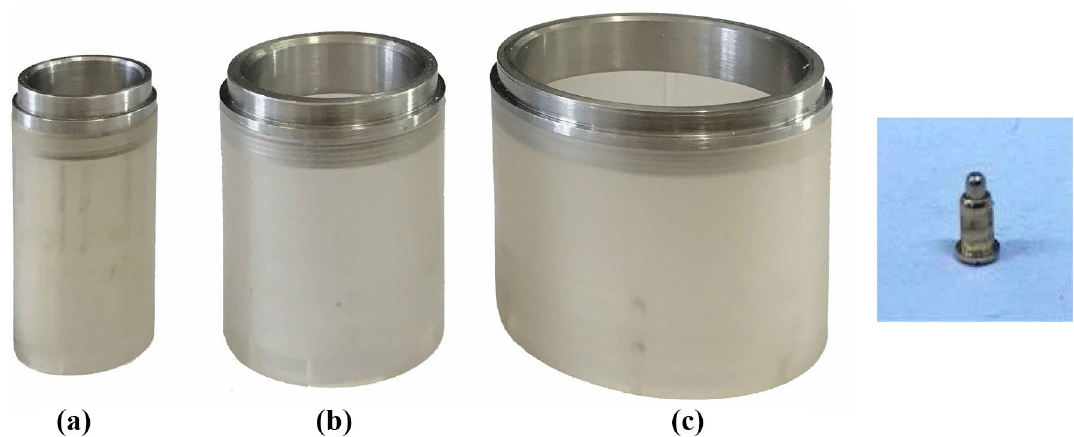
Fig. 12 Photos of MCPA with different D values and gold-plated electrode: a D = 20 mm, b D = 30 mm, c D = 50 mm, d h = 2 mm, d = 1.5 mm